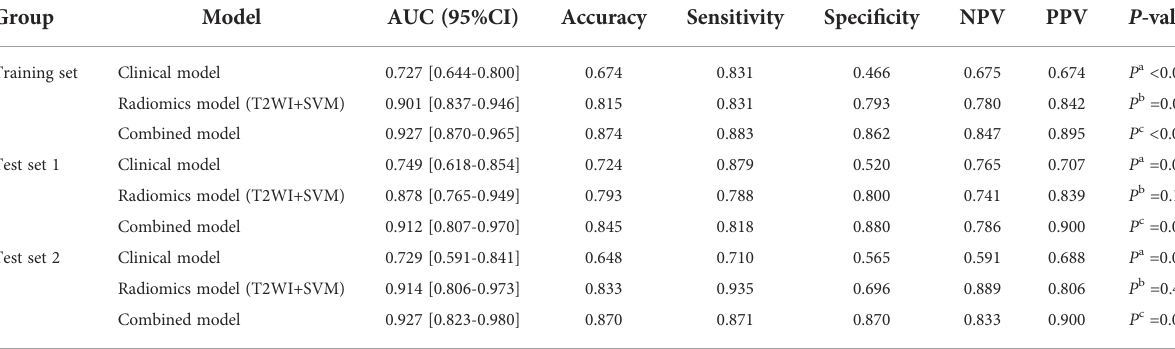
TABLE 5 Diagnostic performance of the clinical model, the radiomics model and the combined model.